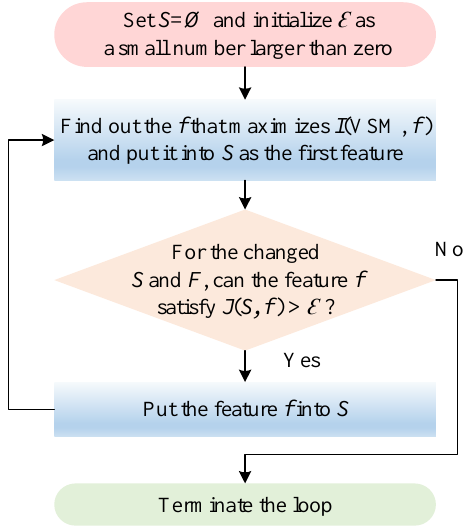
Figure 5. Loop flow for the subset processing.